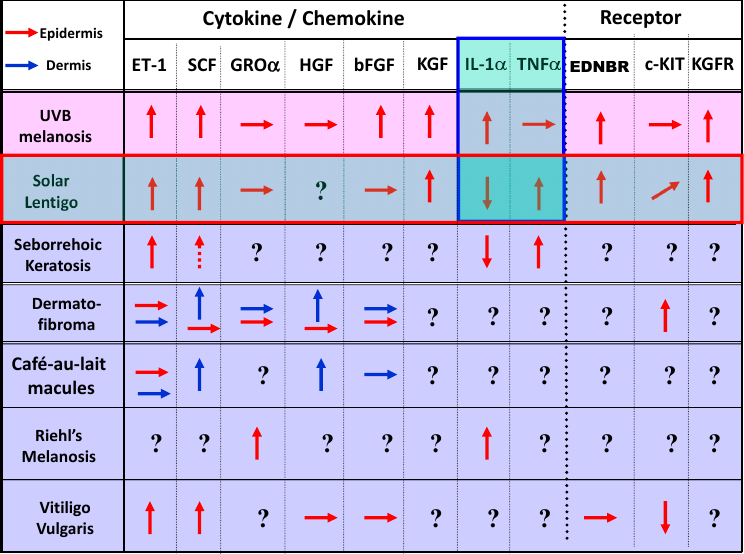
Table 1. Changes in the expression of cytokines, chemokines, and receptors in the lesional epidermis of several hyperpigmentary disorders when compared with non-lesional skin [8,25,30].